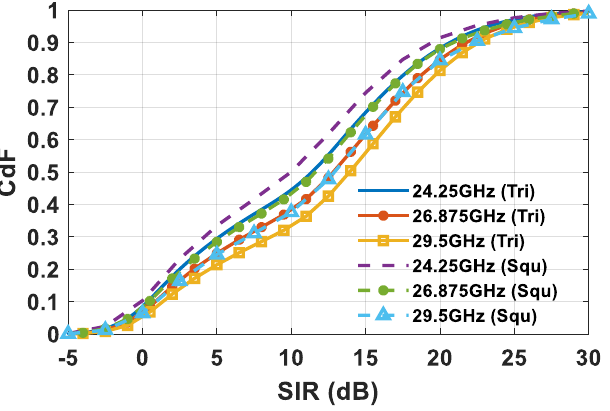
Figure 17. SIR CDF comparison for a planar array composed of 8x8 elements, in cases of square and triangular lattices, in the event of 8 concurrent users. Table 3. Simulated average SIR ( η SIR ) in dB and SIR 90% across triangular and square lattice planar arrays composed of 64 elements (8 × 8), in the event of 8 served users inside the circular sector. 24.25 GHz